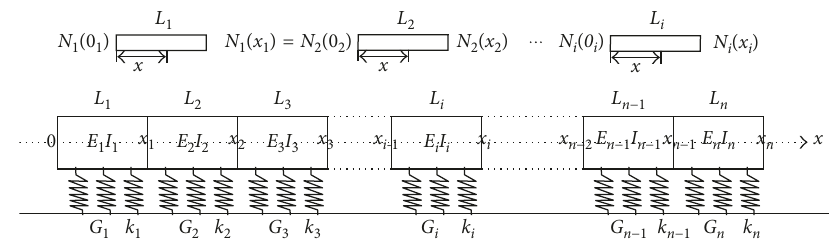
Figure 18: The matrix transfer